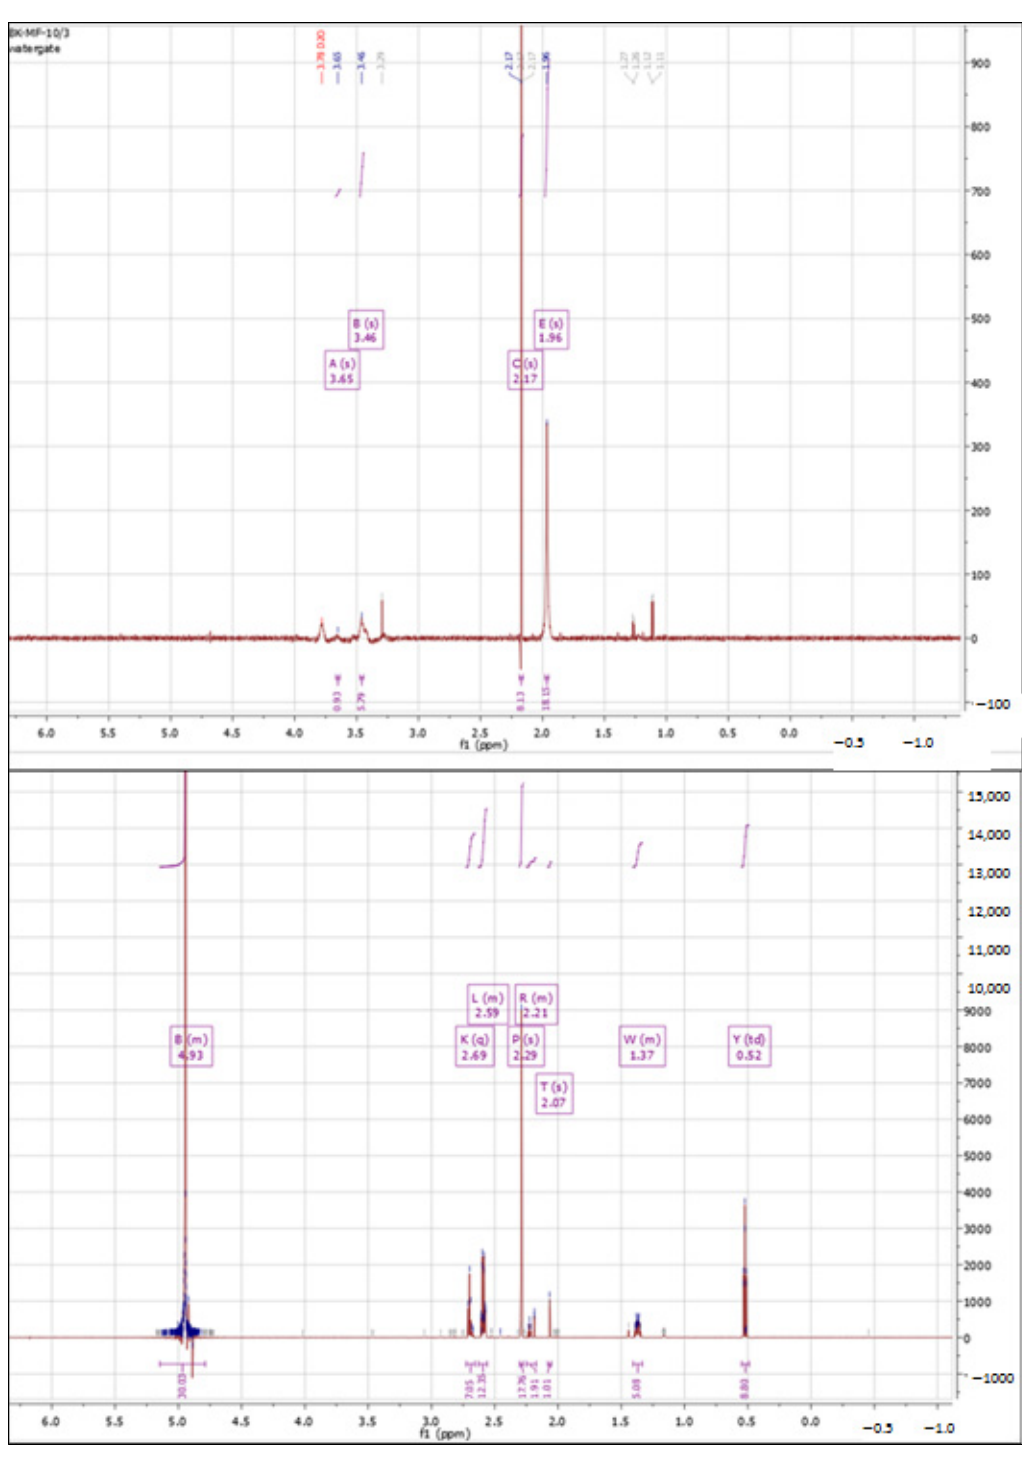
Figure 2. 1 H NMR spectra of native HA ( top ) vs. HA cross-linked with butanediamine ( bo tt om ).